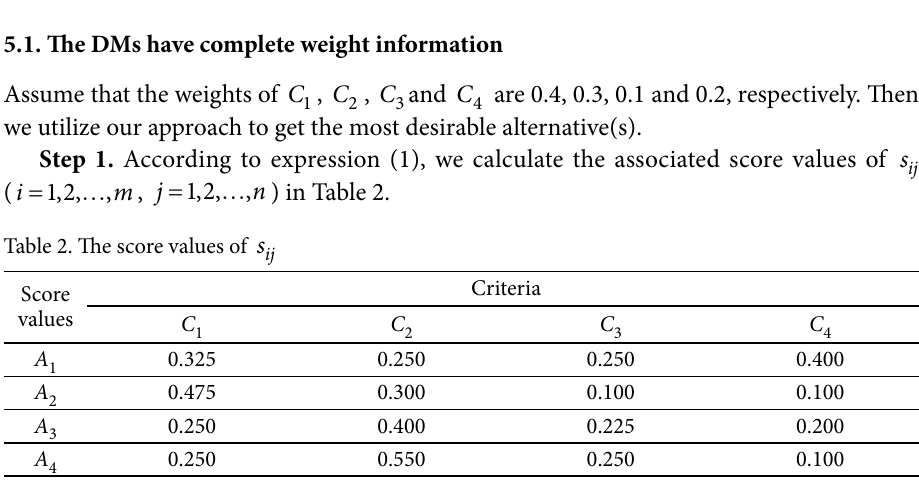
Table 3. The accuracy values of s Accuracy